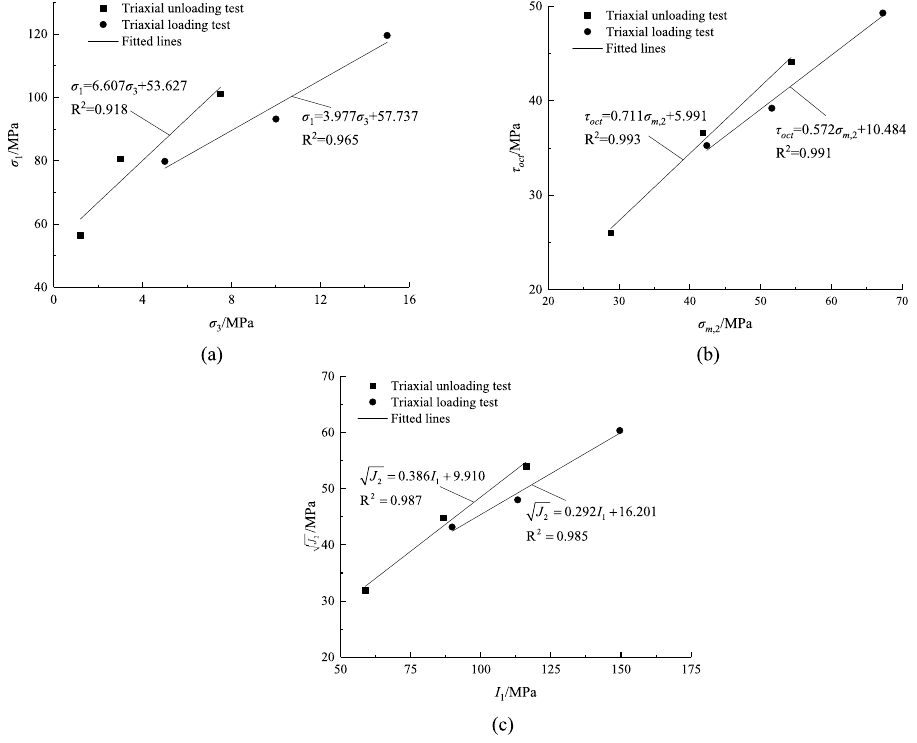
Figure 6. Three kinds of strength criterion regression fitting: ( a ) Mohr–Coulomb, ( b ) Mogi–Coulomb, ( c ) Drucker–Prager.